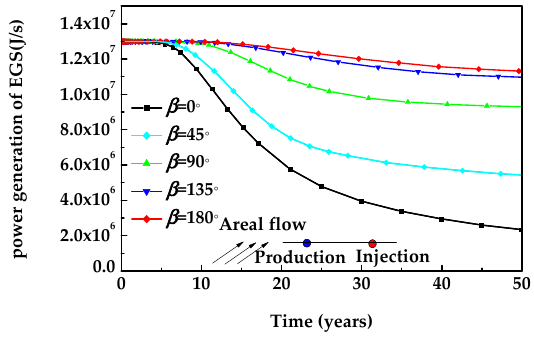
Figure 13. Power generation of EGS with time.